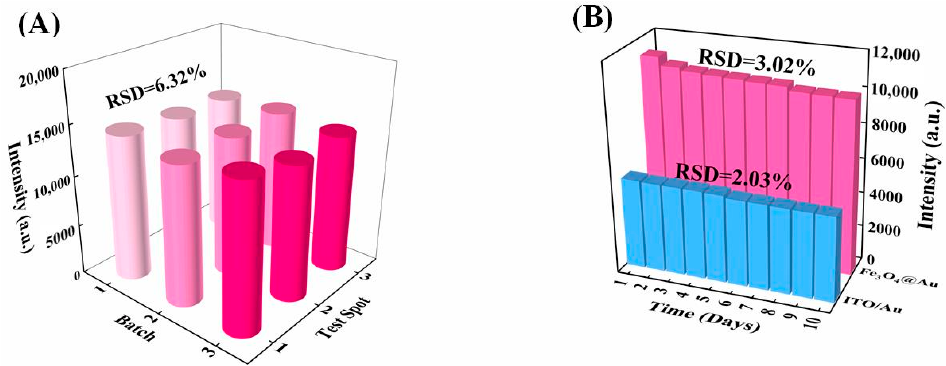
Figure 7. ( A ) SERS signals of R6G recorded from nine preparation batches of ITO/Au. ( B ) Storage stability check of R6G on ITO/Au and using Fe 3 O 4 @Au after 10 days.